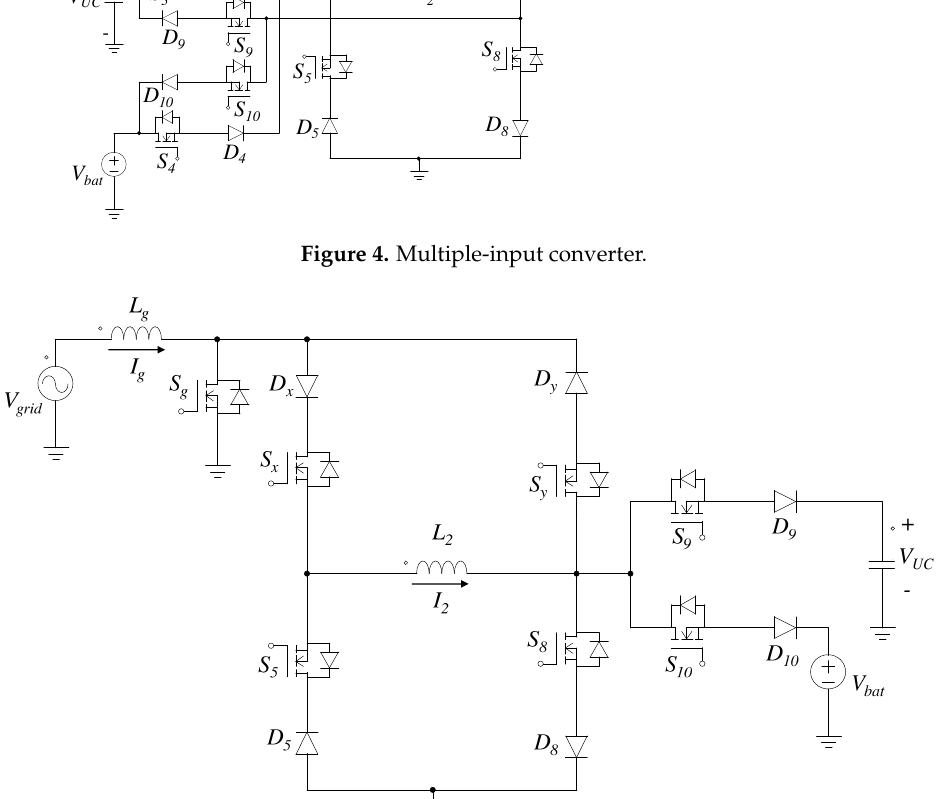
Figure 5. Circuit of the converter when it is needed the charge of the ultracapacitor (UC) or the